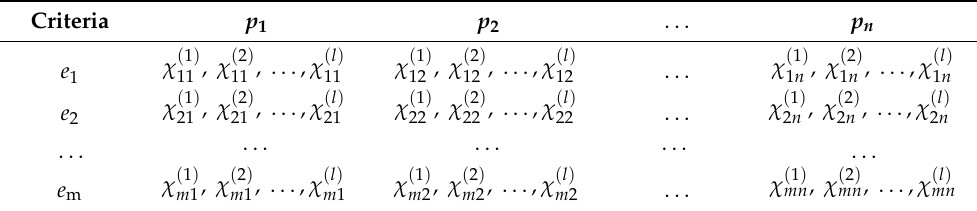
Table 1. MCDM decision